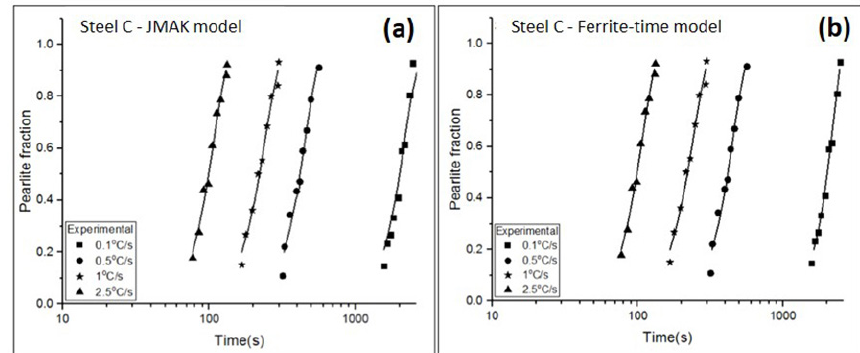
Figure 10. Pearlite fraction as a time function. (a) JMAK and (b) Ferrite-time equations fitted to the steel C experimental